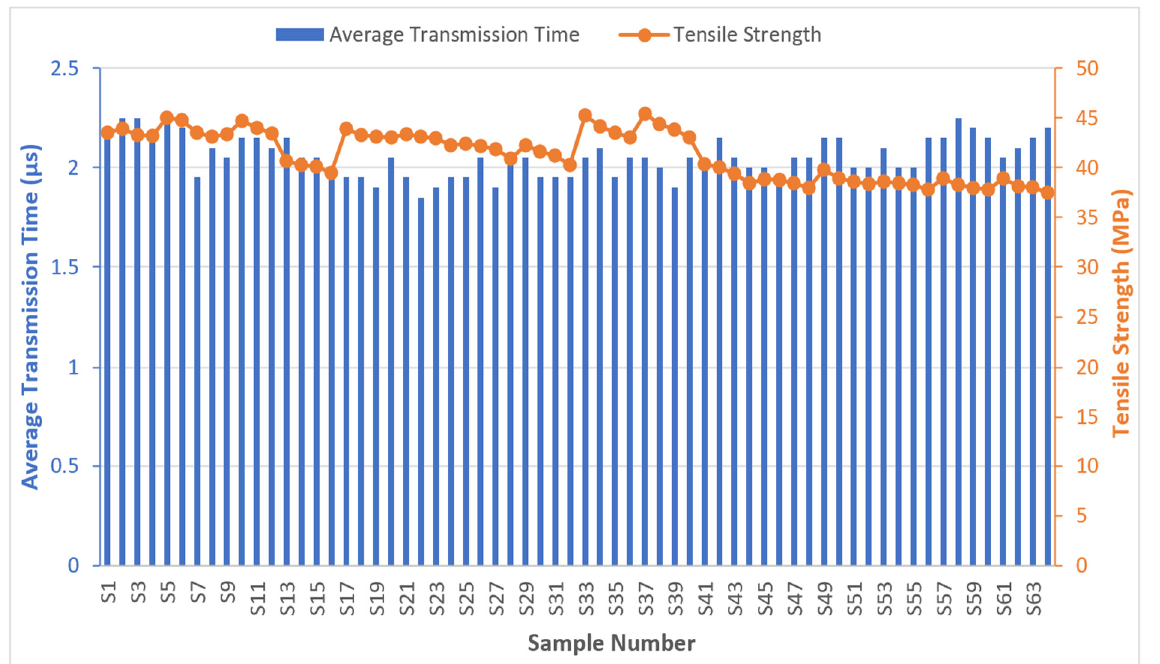
Figure 7. Correlation between average transmission times and tensile strength.